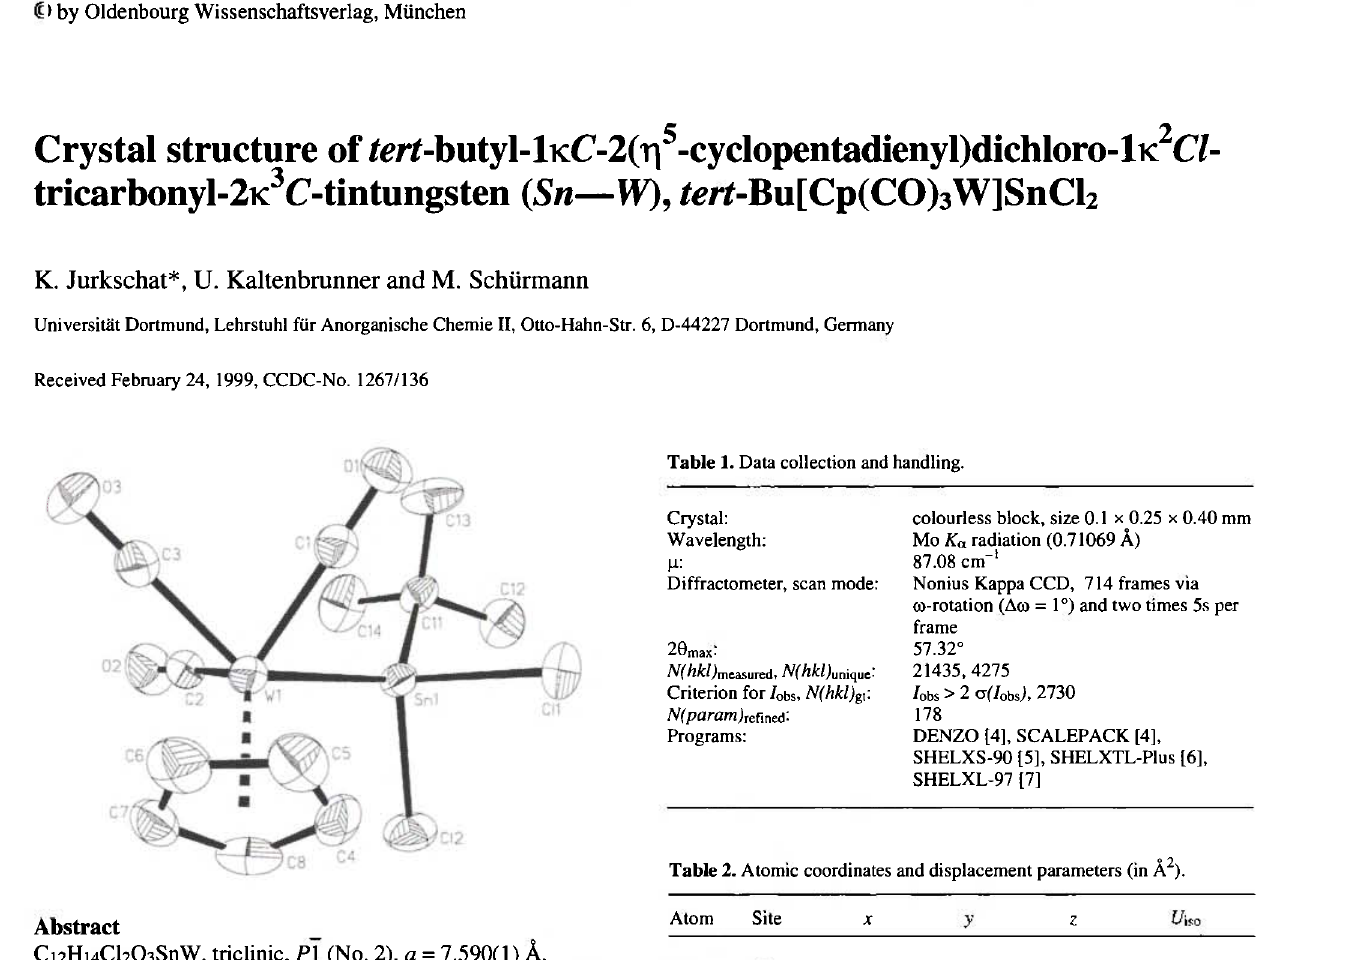
Table 2. Atomic coordinates and displacement parameters (in Ä 2